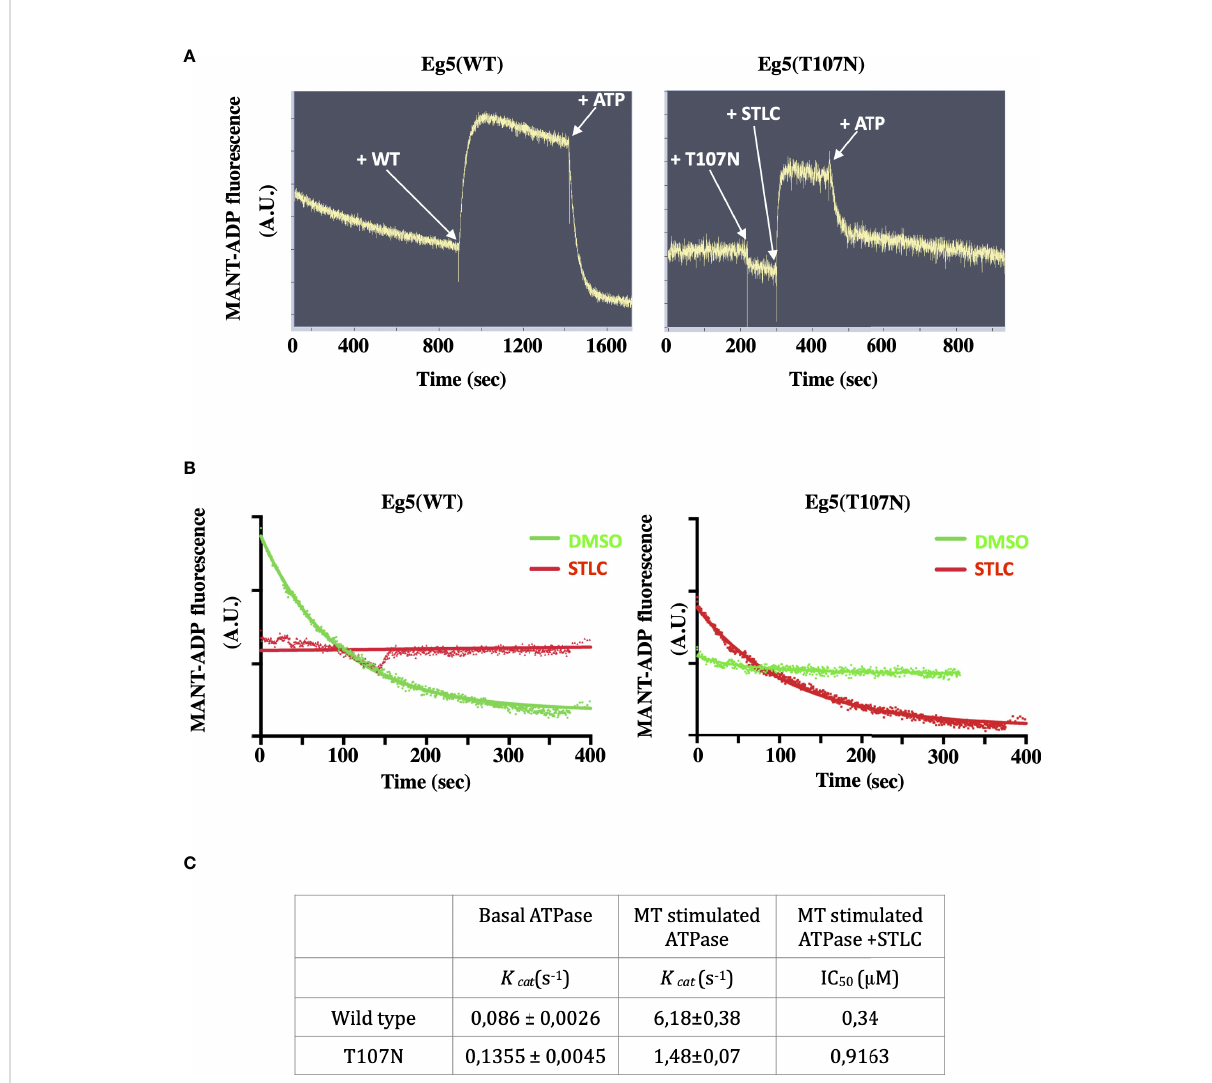
FIGURE 8 STLC dependent binding of ATP in the nucleotide pocket of Eg5(T107N) motor domain. (A) FRET of Mant-ADP is detected upon addition of the Eg5(WT) motor domain and is lost after been chased by the addition of cold ATP. In contrast, FRET of Mant-ADP is not detected upon addition of the Eg5(T107N) domain unless STLC is added. (B) Nucleotide exchange in the Eg5-STLC complex. Once STLC is bound to the Eg5(WT) pre- incubated with Mant-ADP the nucleotide is not exchangeable. Pre-incubation with DMSO allows the chase of Mant-ADP by ATP. In contrast, there is an exchange of the nucleotide in the Eg5(T107N)-STLC complex but not in the in the absence of STLC (DMSO control). (C) Kinetic parameters of the basal ATPAse activity of Eg5(WT) and Eg5(T107N) and the microtubule stimulated ATPase in the presence or the absence of